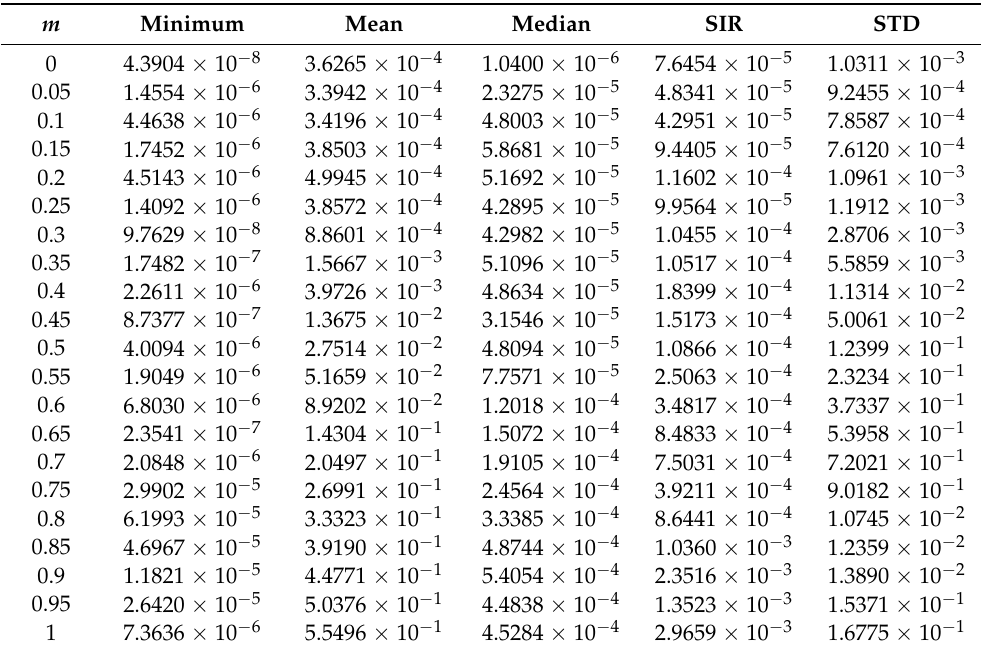
Table 1. Statistical measures for the stochastic operators based on case 1 for the NSPM-SK.